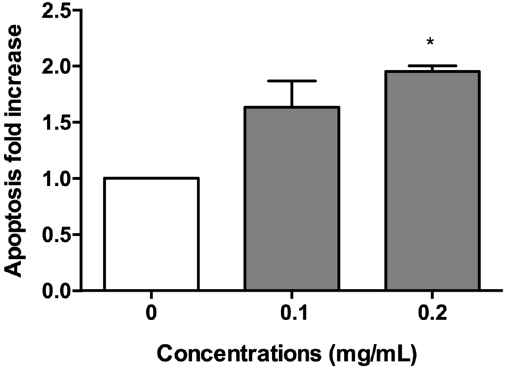
Figure 4. Apoptosis fold increase on TK6 cells after 3 h treatments with A. leucotrichus (0.1 and 0.2 mg/mL) followed by 23 h of recovery in the complete medium at the indicated concentrations compared to untreated cultures (0). * p < 0.05 vs. 0.